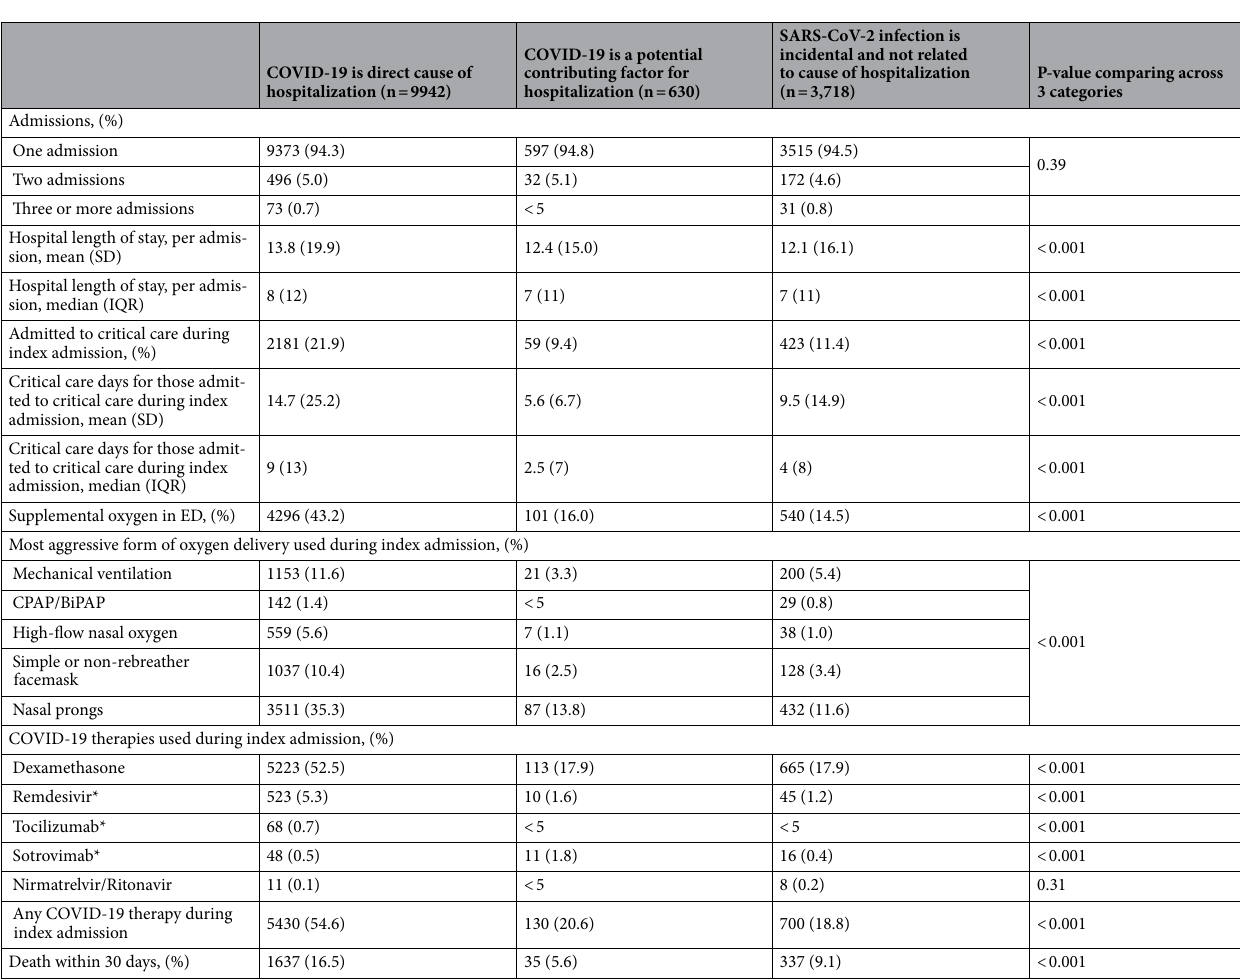
Table 2. Acute care utilization and outcomes, by most responsible diagnosis. ED Emergency Department, SD standard deviation, CPAP Continuous positive airway pressure, BiPAP Bilevel airway pressure. *Likely an under-count as not collected routinely until Feb, 2021.